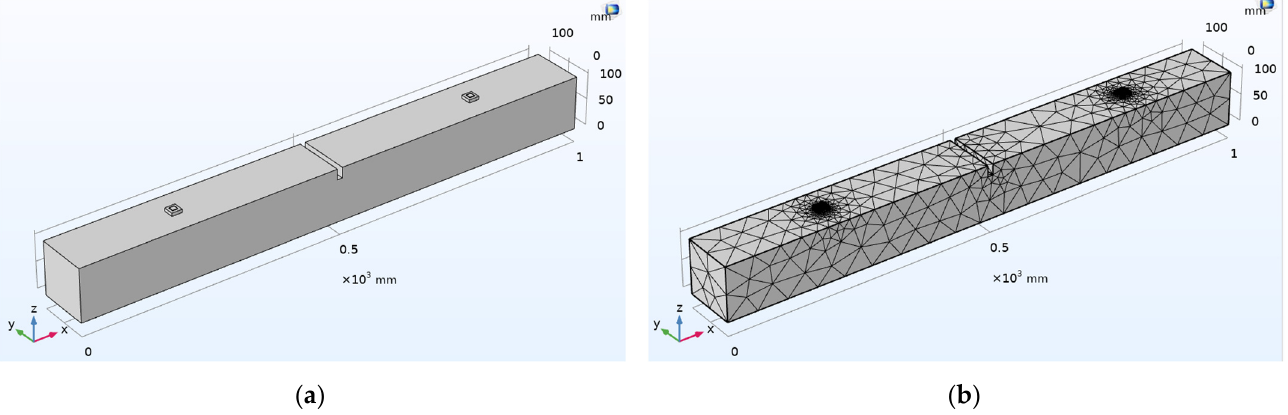
Figure 21. Combined EMI-WP measurement: ( a ) 3D model; ( b ) FE model of a damaged concrete